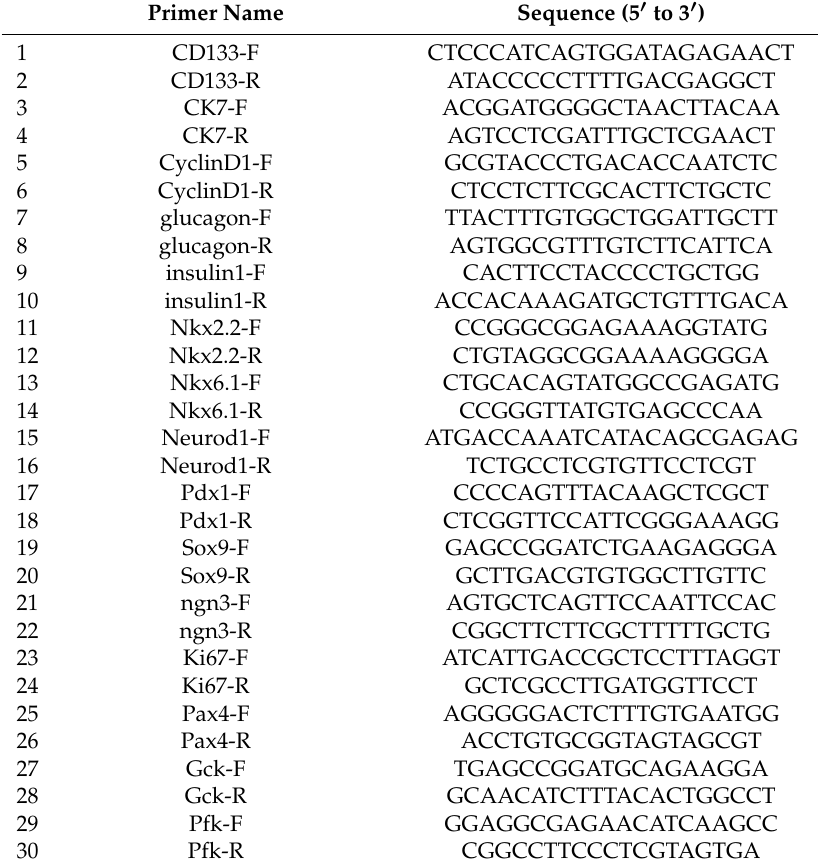
Table 1. Primers used in